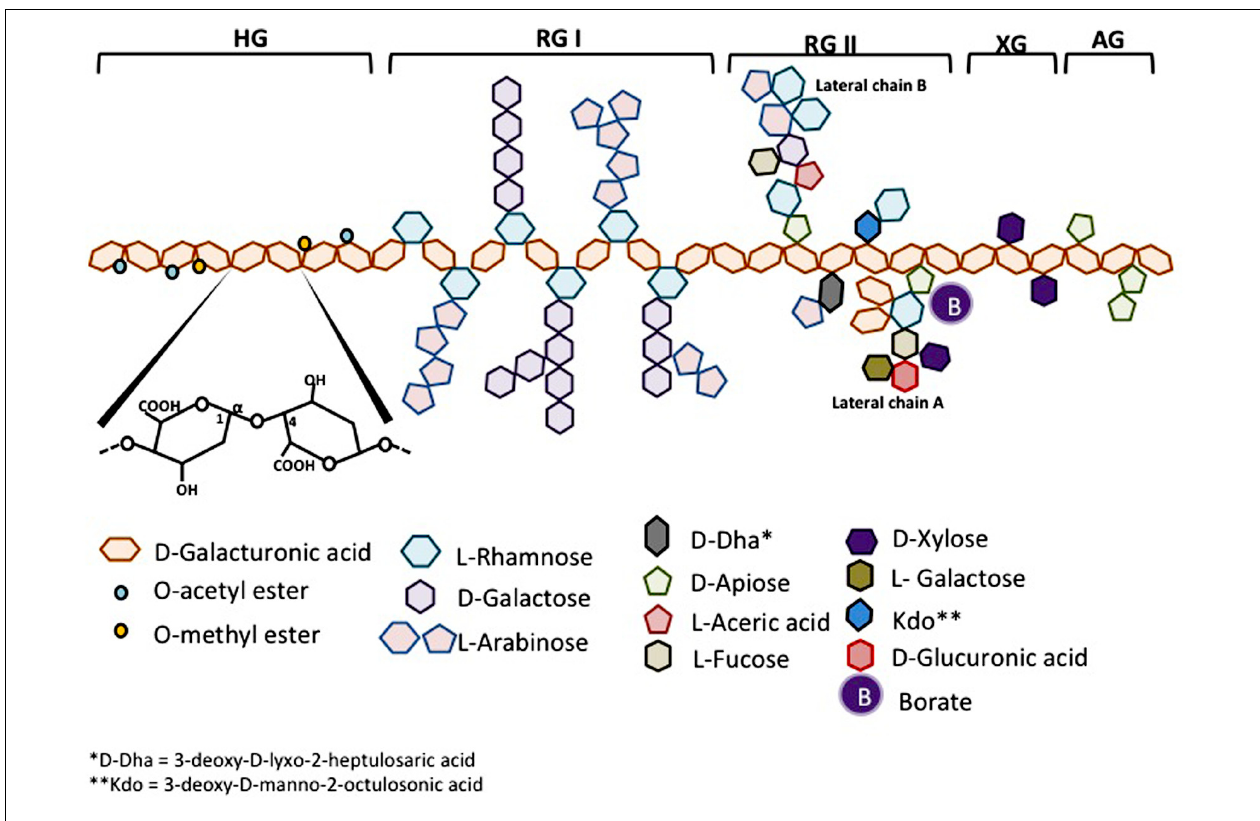
FIGURE 1 | Schematic representation of pectin structure . AG, arabinogalactan; HG, homogalacturonan; RG, rhamnogalacturonan; XG, xylogalacturonan.